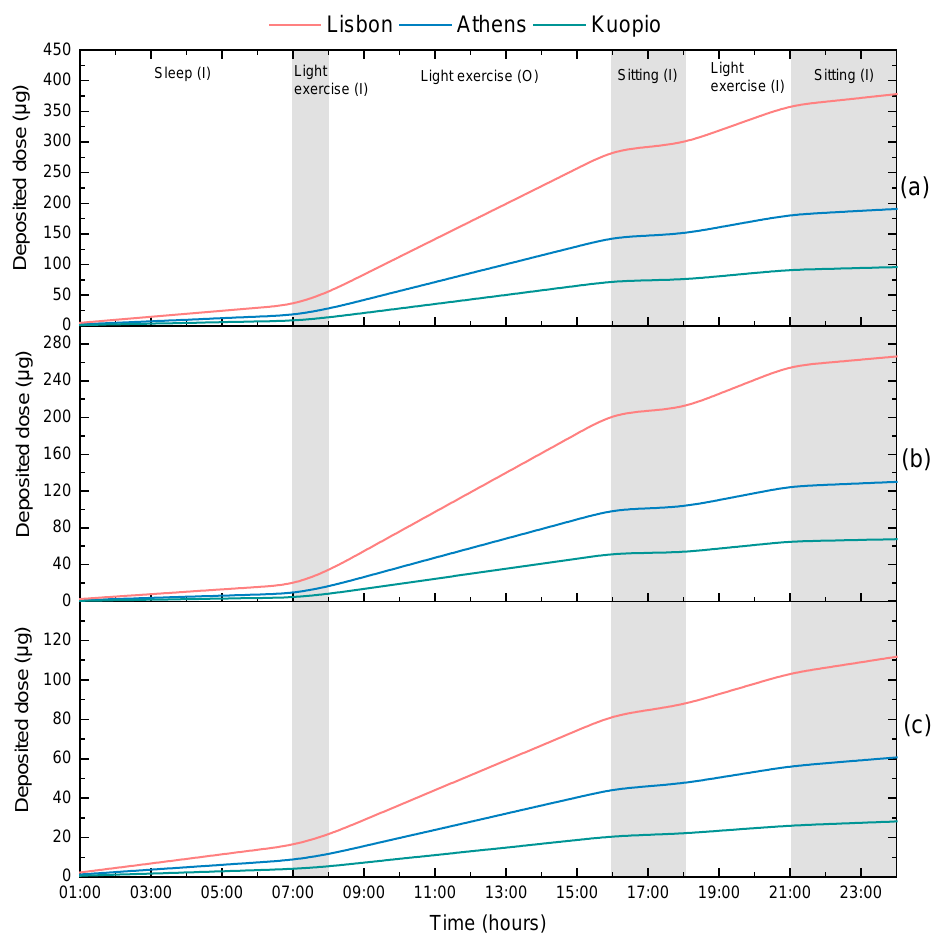
Figure 2. Cumulative deposited dose (μg) of particulate matter in the ( a ) respiratory tract, ( b ) ET (ET1+ET2) region and ( c ) lung (BB+bb+AI) region for an adult male in the three under study cities. (I) represents indoors and (O) outdoors.